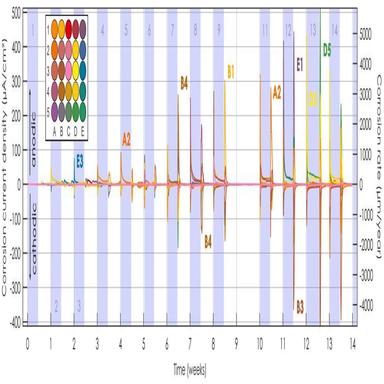
Anodic and cathodic currents for the CEM IV specimen over 14 weeks of exposure to cyclic wetting and drying.